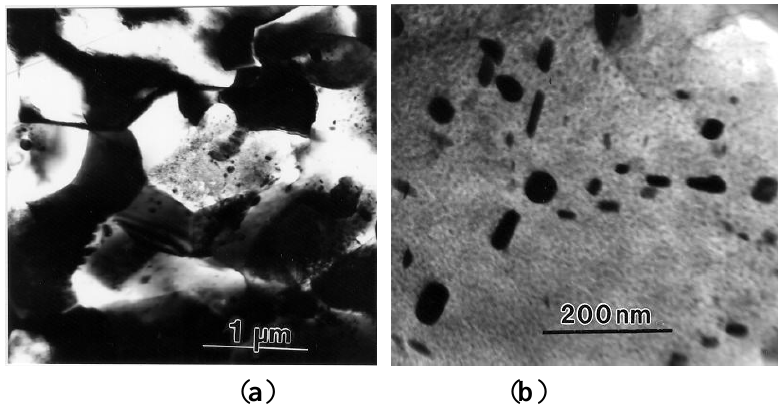
group of grains; and ( b ) high magnifications microscopy showing dispersion distribution in a grain.